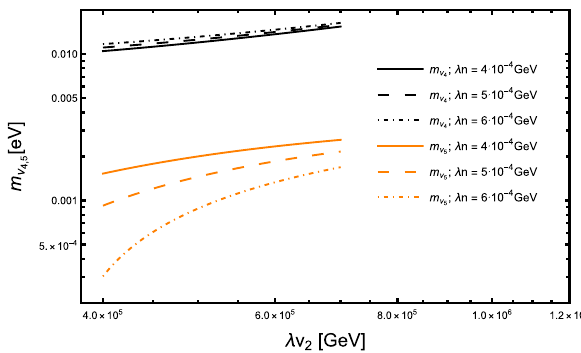
Fig. 6 Parametric scan for the mass values of the lightest neutrino states m ν 4 , 5